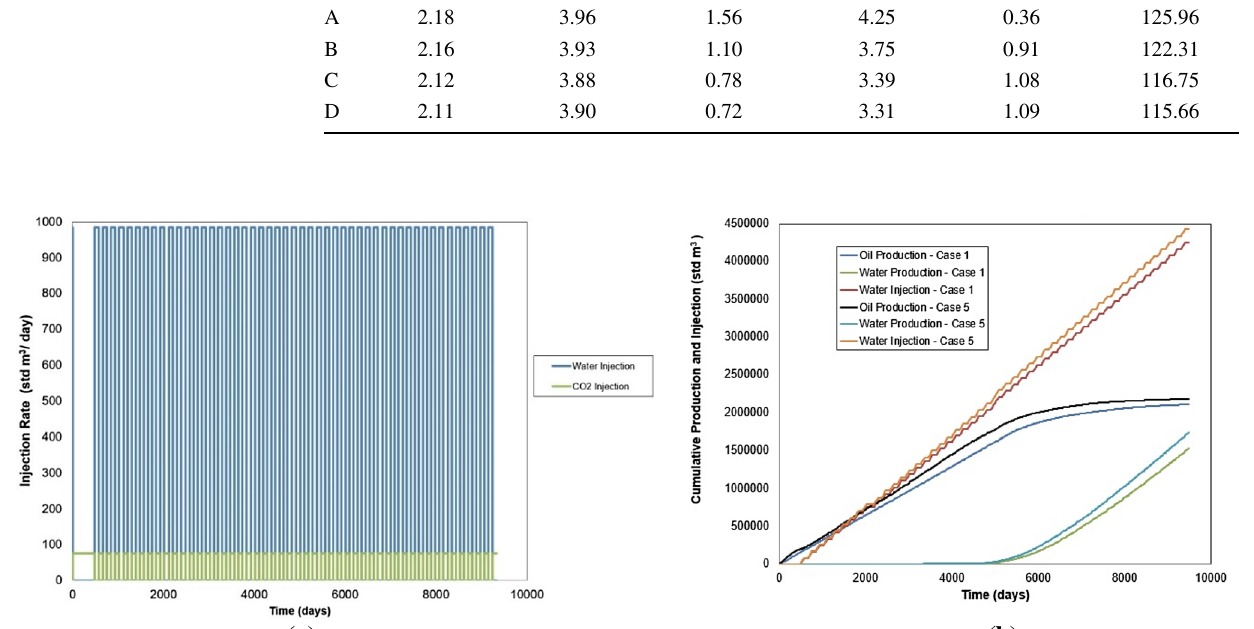
Fig. 7 Graphs of ( a ) water and CO 2 injection rate curves and ( b ) cumulative production and injection for WAG recovery in case 4 in comparison with the base case Table 13 Results of case 5 (with hysteresis, solubility and CO